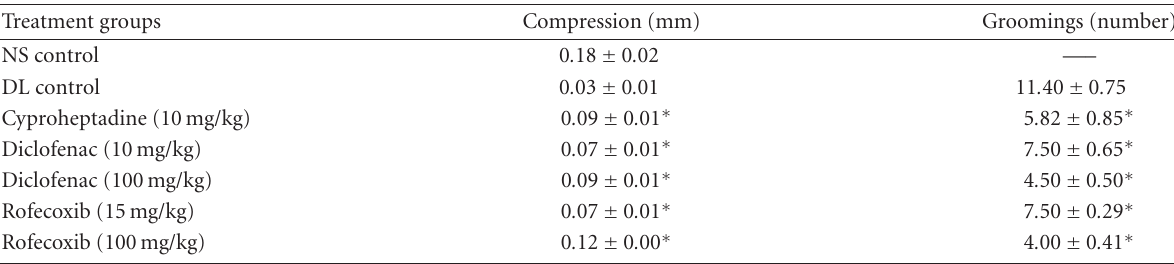
Table 1. E ff ect of various drugs on DL-induced inflammatory hyperalgesia and associated behavioral changes. Edema was induced by injecting 0 . 1mL of 1% solution of DL into subplantar surface of right hind paw. The drugs were administered orally 1hour before injecting DL. Extent of compression and number of groomings were recorded at 2 hours. The values given are mean ± standard error of the mean ( n =